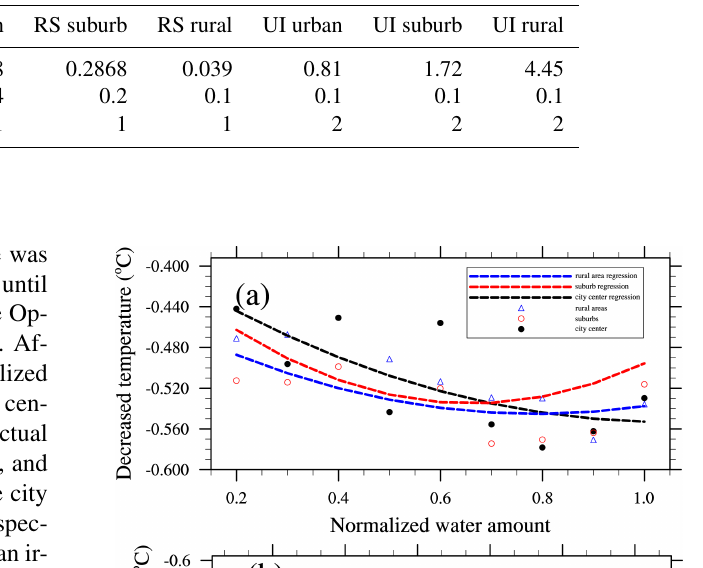
Table 5. Constraint conditions for water usage in urban, suburban, and rural areas.